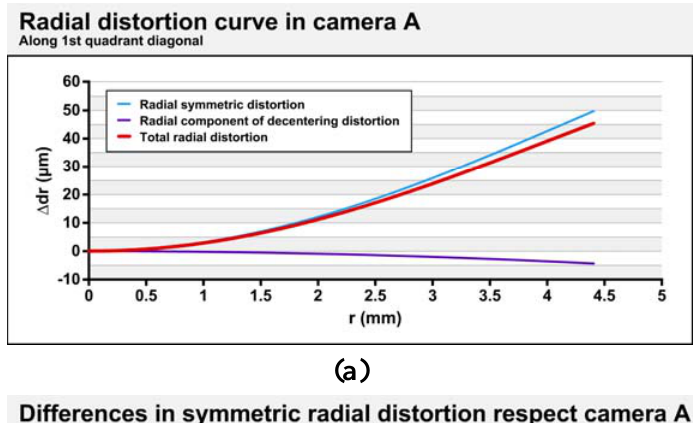
Figure 2. (a) Radial distortion curve in camera A, (b) differences in symmetric radial distortion curves of cameras B,C and D respect camera A, (c) differences in total radial distortion curves of cameras B,C and D respect camera A and (d) tangential component of decentering distortion curve of cameras A,B,C and